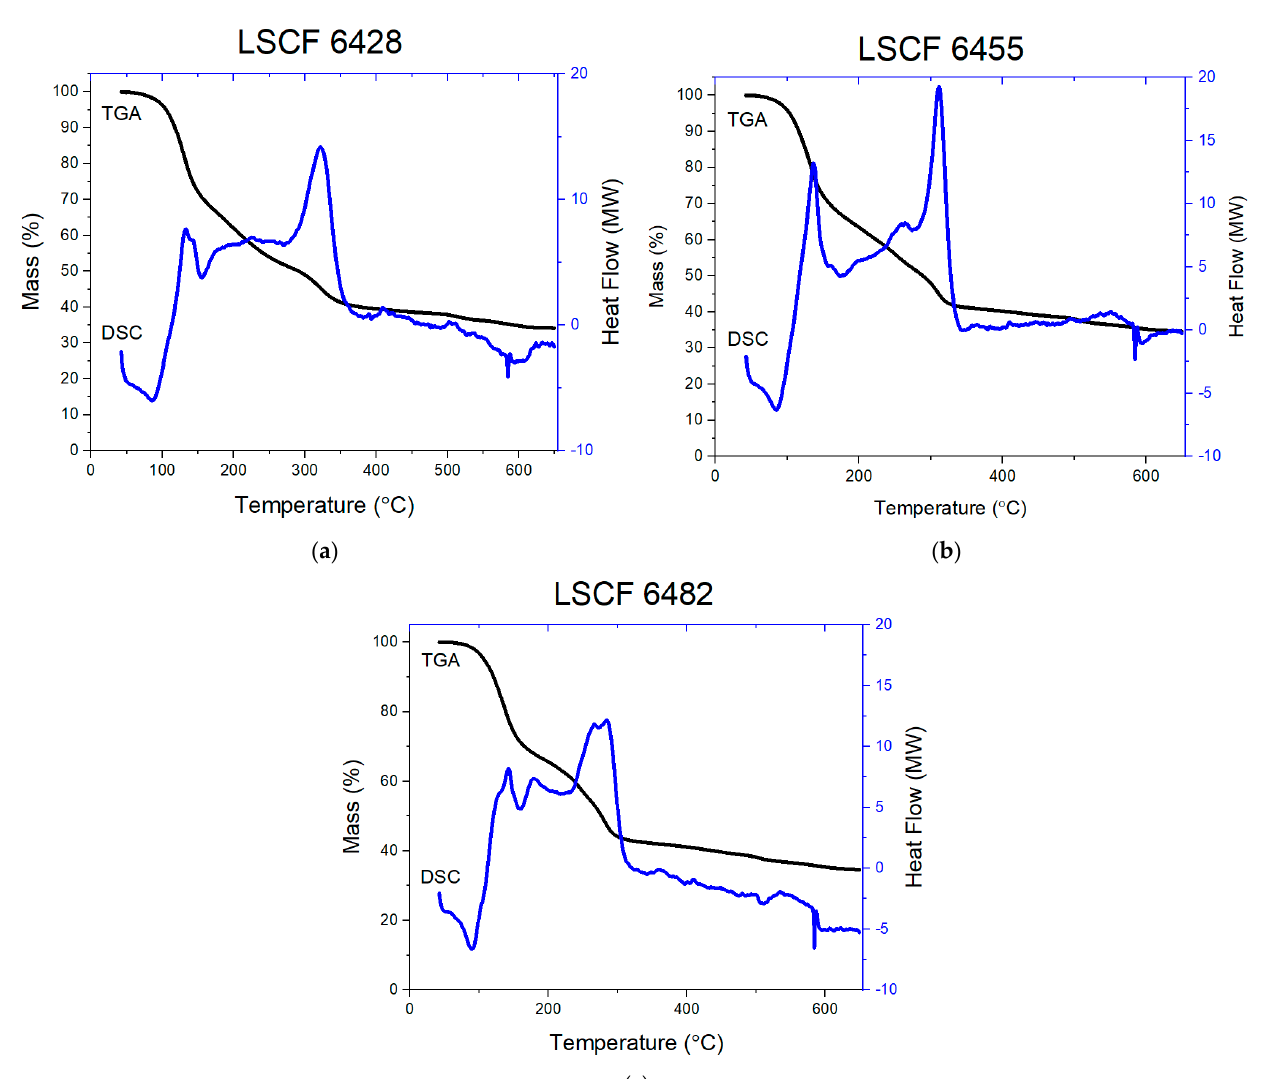
Figure 2. Thermal analysis of: ( a ) LSCF 6428; ( b ) LSCF 6455; ( c ) LSCF 6482.